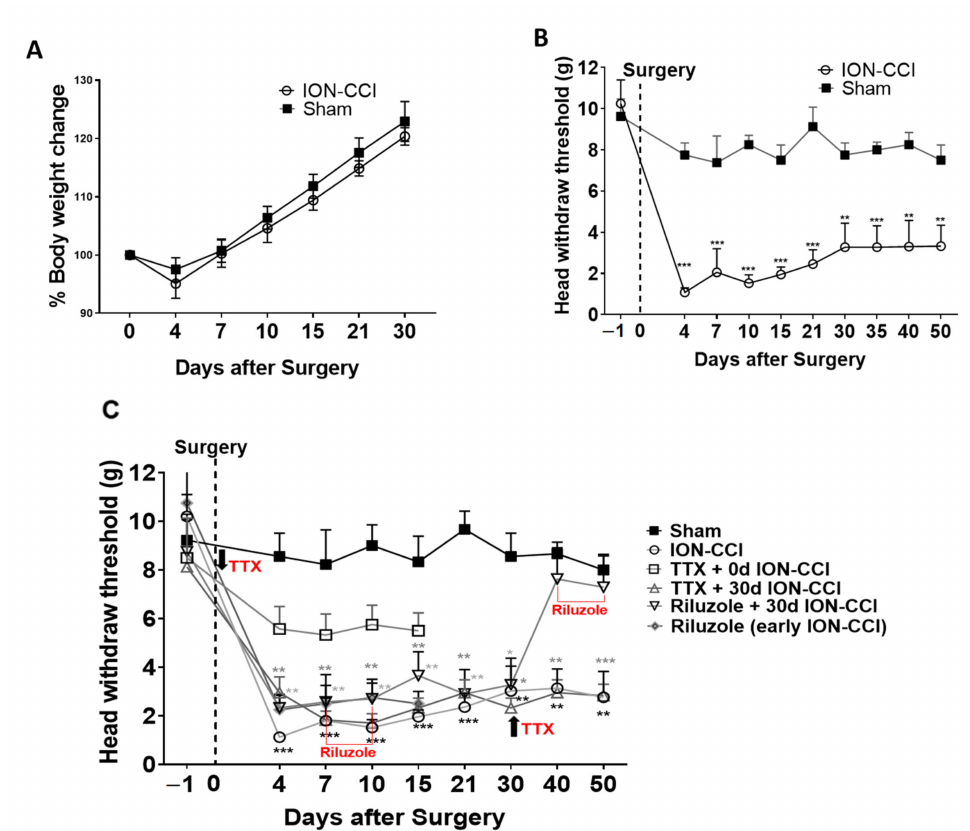
Figure 1. Mechanical nociceptive pain behavior in trigeminal neuropathic pain rats with various pharmacological interference. ( A ) The percentage change of body weight in sham and ION-CCI rats during 30 days following surgerycompared to that of bodyweight on pre-surgery day. Statis- tical significance was determined by two-tailed unpaired t -test. ( B ) Time course of changes in the head-withdrawal threshold to mechanical stimulation of the orofacial skin region ipsilateral to the constricted nerve site in sham rat and ION-CCI rat. Results are presented as mean ± SEM, n = 8 for sham group and n = 8 for ION-CCI group. Statistical significance was determined by two-tailed unpaired t -test. ION-CCI vs. sham ** p < 0.01, *** p < 0.001. ( C ) Drug treatment groups for pain relief are compared with sham and ION-CCI rats. For immediate treatment group, TTX treatment was provided immediately on the day of CCI surgery, whereas for late treatment group, TTX treatment was provided 30 days after CCI surgery in ION-CCI rats. Bilateral intra-ACC infusion of riluzole provided for 5 days in the early stage does not relieve from pain. For late riluzole treatment, intra- ACC riluzole treatment was provided from day 40 repeatedly every 12 h for 4 days, having been shown to relieve the mechanical allodynia in ION-CCI rats on days 40–50. Results are presented as mean ± SEM, n = 10 for TTX immediate after ION-CCI group, n = 8 for TTX after 30-day ION-CCI group, and n = 8 for riluzole after 30-day ION-CCI group. Statistical significance was determined by two-way ANOVA, followed by multiple comparisons adjusted by the Bonferroni’s test, ION-CCI vs. sham ** p < 0.01, *** p < 0.001; TTX (30 d ION-CCI) vs. sham ** p < 0.01, *** p < 0.001, riluzole (30 d ION-CCI) vs. sham * p < 0.05, ** p < 0.01, *** p <